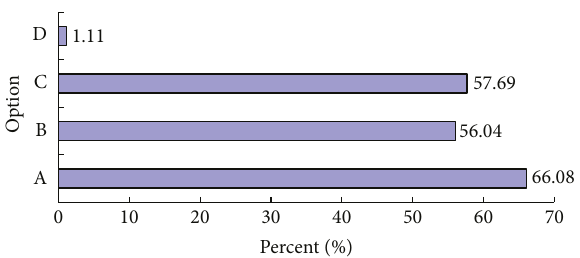
Figure4:Distributionofmeasurestoreducethechancesofrunning a red